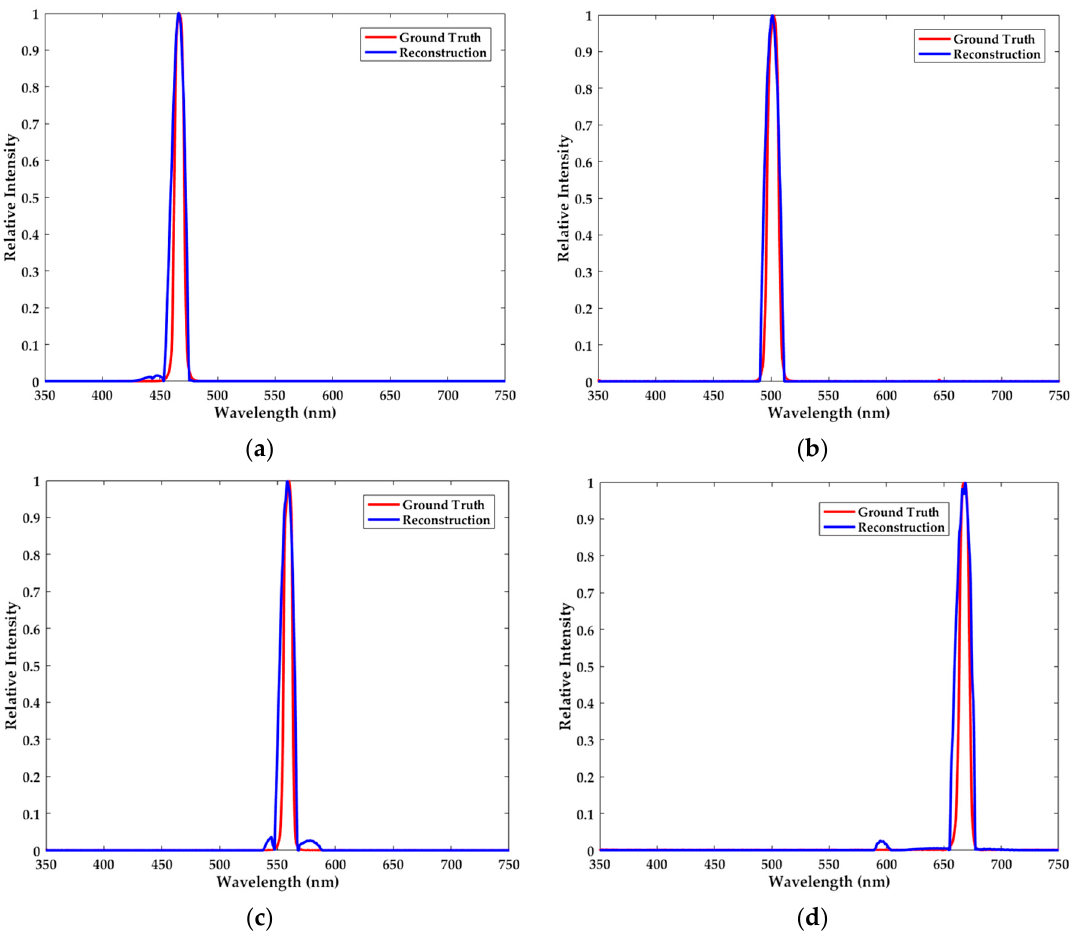
Figure 4. The ground truth spectra (red) and the reconstructed narrowband spectra (blue) with the crest centering at ( a ) 466.5 nm, ( b ) 501.5 nm, ( c ) 558.5 nm and ( d ) 668.5 nm. The passband and the crest of the reconstructed spectra can be accurately determined.